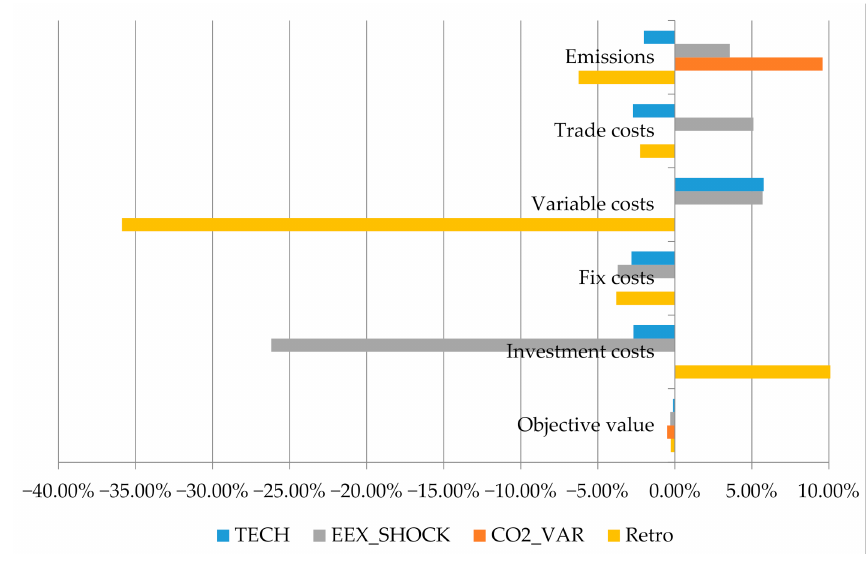
Figure 13. The relative difference between the results of the myopic and the perfect foresight approach in each scenario, the difference is displayed as value = [result perfect foresight − result myopic]/result perfect